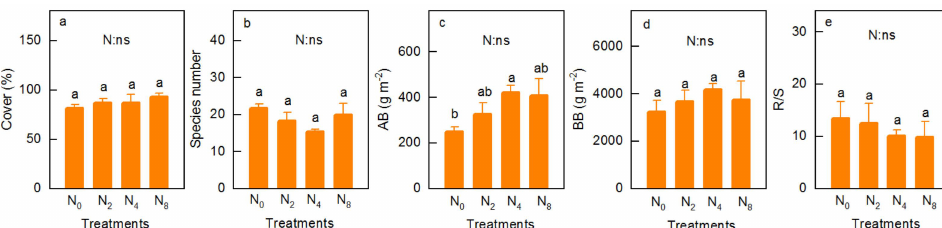
Figure 2. Cover ( a ), species number ( b ), AB ( c , aboveground biomass), BB ( d , belowground biomass) and R/S (root-shoot ratio, e ) under the N addition rates. Different letters on the bars indicate significant difference ( p ≤ 0.05). p -value of the ANOVA of N addition treatments (0, 20, 40 and 80 kg N ha − 1 y − 1 ) is indicated: ns, not significant.